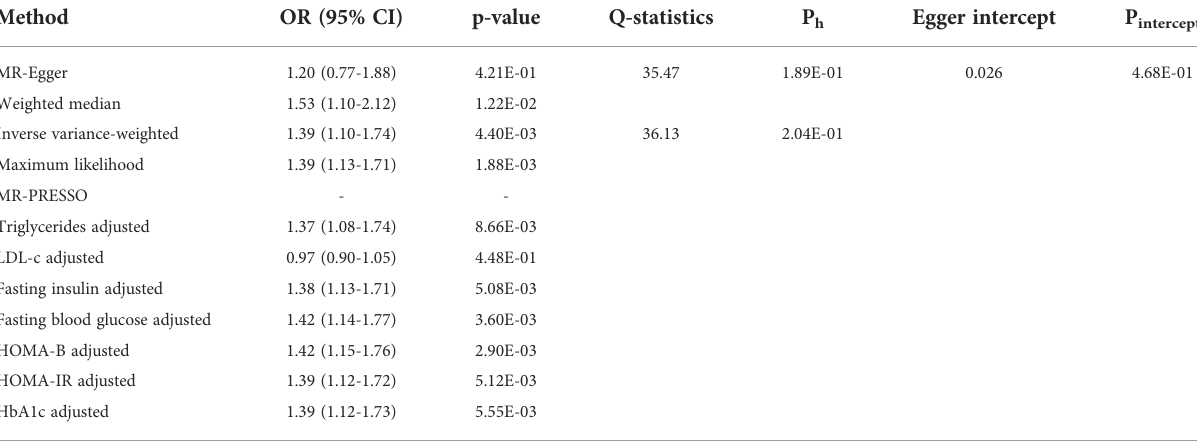
TABLE 3 Univariable and multivariable two-sample Mendelian randomization estimations showing the effect of type 1 diabetes mellitus on the risk of IgA nephropathy.